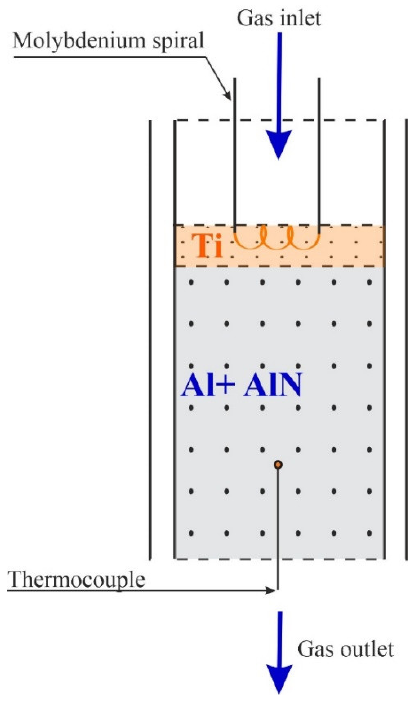
Figure 1. Scheme of the flow-through SHS reactor.